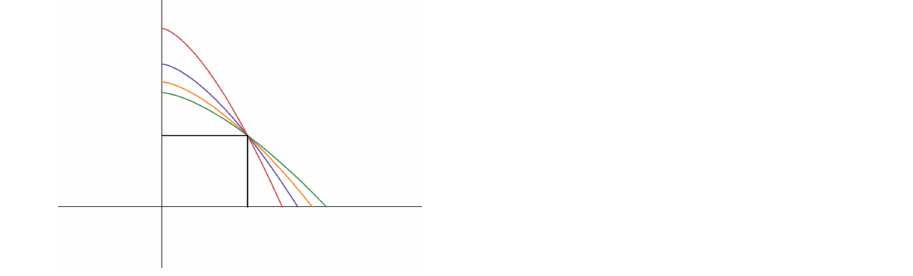
Figure 1. An illustration of the problem’s setup, where the rectangle’s width is k = 2.4, the height is t = 2 and the degree of the family r = 1.5. Each curve defines the area and curve length. Given the rectangle’s width, we show that there exists a height such the curve which minimizes the area and the curve which minimizes the length coincide (see Figure 2 for an